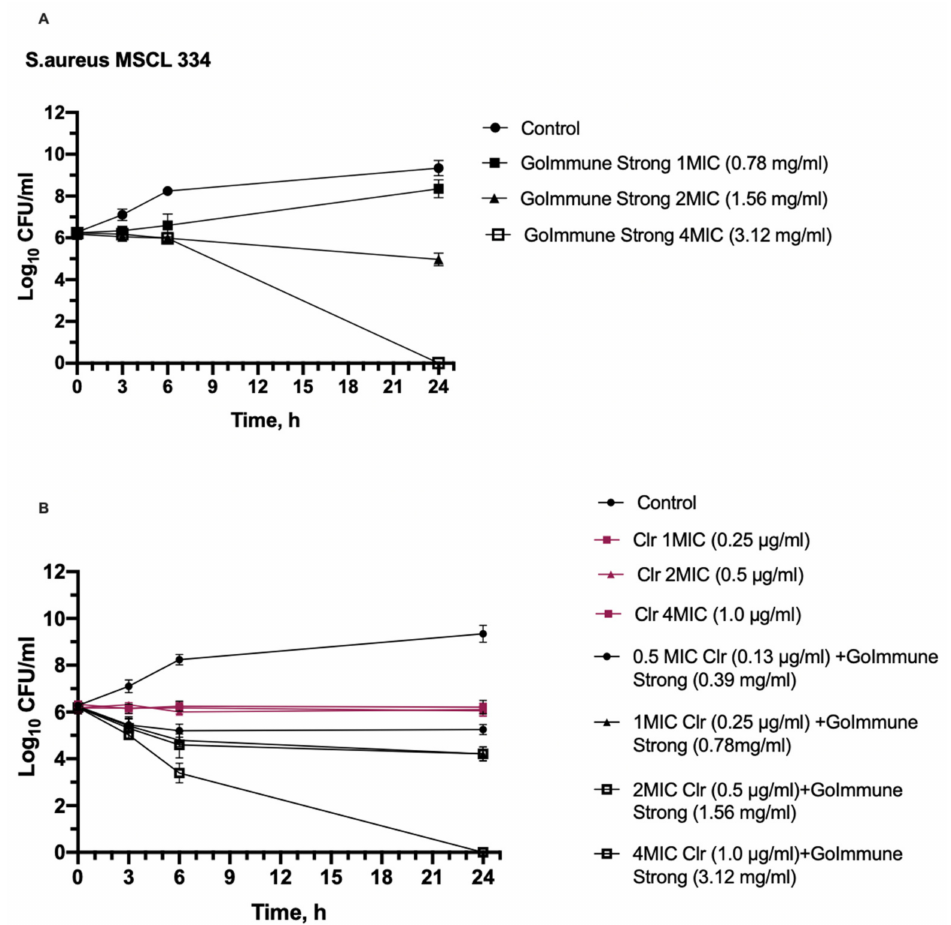
Figure 2. Time-kill curves show synergistic interaction between GoImmune Strong ® complex and clarithromycin (Clr) against S. aureus . ( A )—time-kill curves of GoImmune Strong ® complex at different concentrations. ( B )—Time-kill curves of combination of GoImmune Strong ® complex and clarithromycin. Each time-curve experiment was performed in duplicate and diluted samples were plated in duplicate on agar plates. Error bars indicate standard